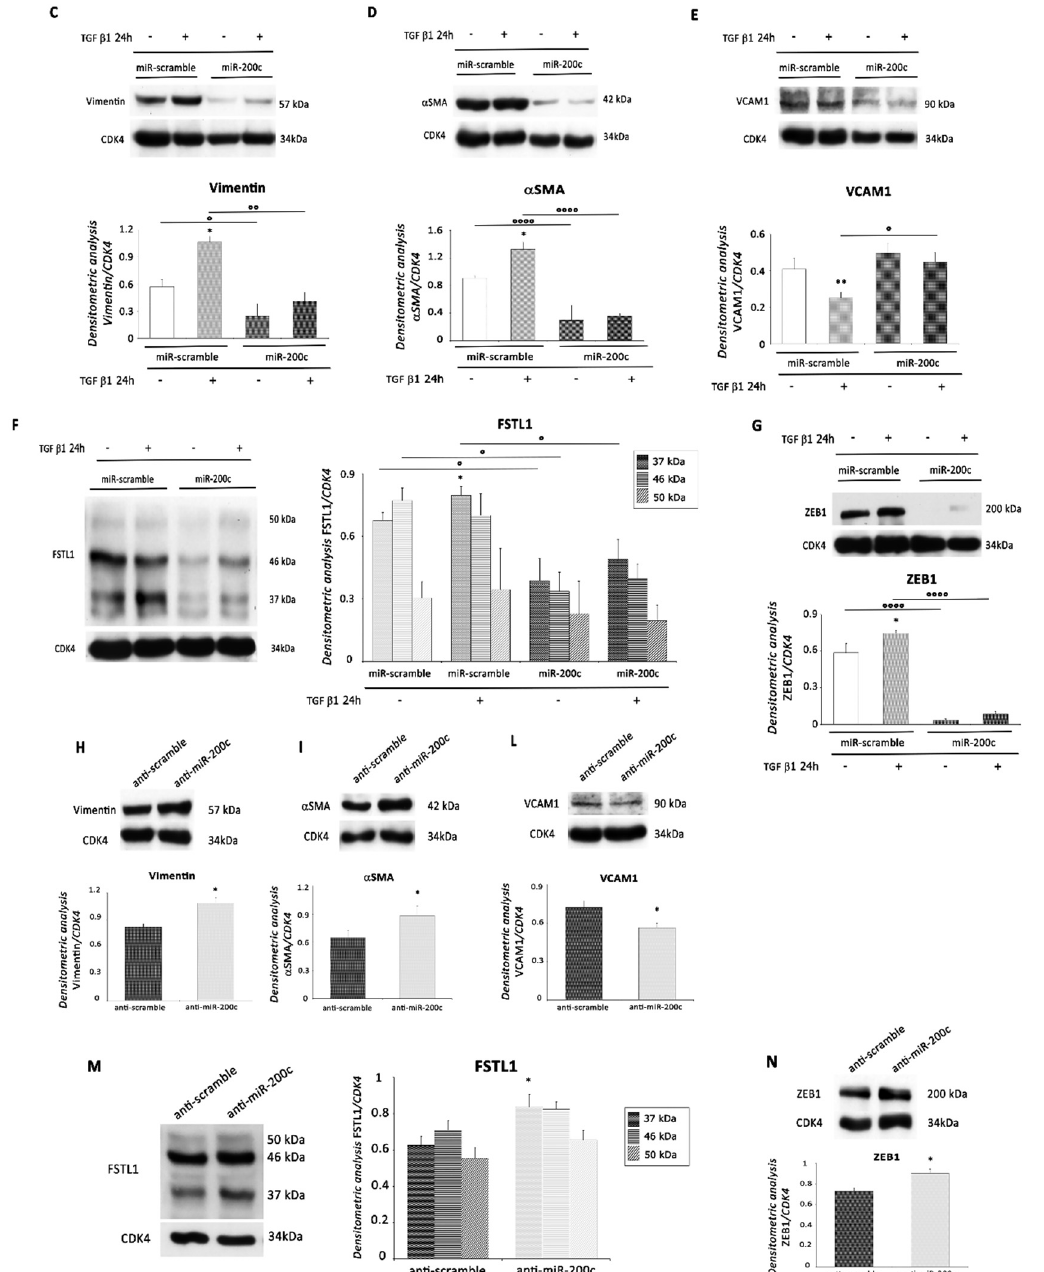
Figure 7. miR-200c inhibits the EMT by Targeting FSTL1. ( A ) FSLT1 is a direct target of miR-200c. HEK 293 were transfected with firefly luciferase constructs containing the murine 3 (cid:48) UTR- FSTL1 wt or the 3 (cid:48) UTR sequence mutated in miR-200c seed sequence (3 (cid:48) UTR-FSTL1 mut) both cloned in pEZX-MT06 plasmid. These constructs were co-transfected with a plasmid encoding either miR-200c or a miR-scramble sequence as a control. Values were normalized according to renilla luciferase activity ( n = 5 in triplicate; **, p <0.001). miR-200c down-modulated the luciferase activity of the 3 (cid:48) UTR wt construct but not that of the mutated construct. ( B – G ) EMC cells were infected with a lentivirus encoding miR-200c or with a control virus. After 24 h, cells were selected with puromycin and plated. ( B ) miR-200c expression levels in EMCs infected with control virus or with the lentivirus encoding miR-200c. *, p < 0.05 The cells were then treated with TGF β 1 (1 ng/mL) for 24 h and subjected to WB analysis of the EMT specific markers ( C ) Vimentin, ( D ) α SMA, and ( E ) VCAM1 and the direct targets ( F ) FSTL1 and ( G ) ZEB1. Upper panel (or left panel for FSTL1): A representative Western blotting of three independent experiments is shown. Lower panel (or right panel for FSTL1): Densitometric analysis of Western blot. Data are shown